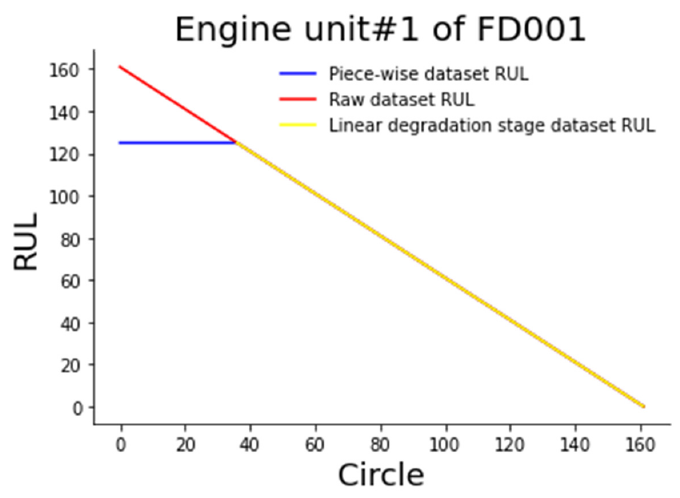
Figure 4. Linear degradation stage dataset RUL.